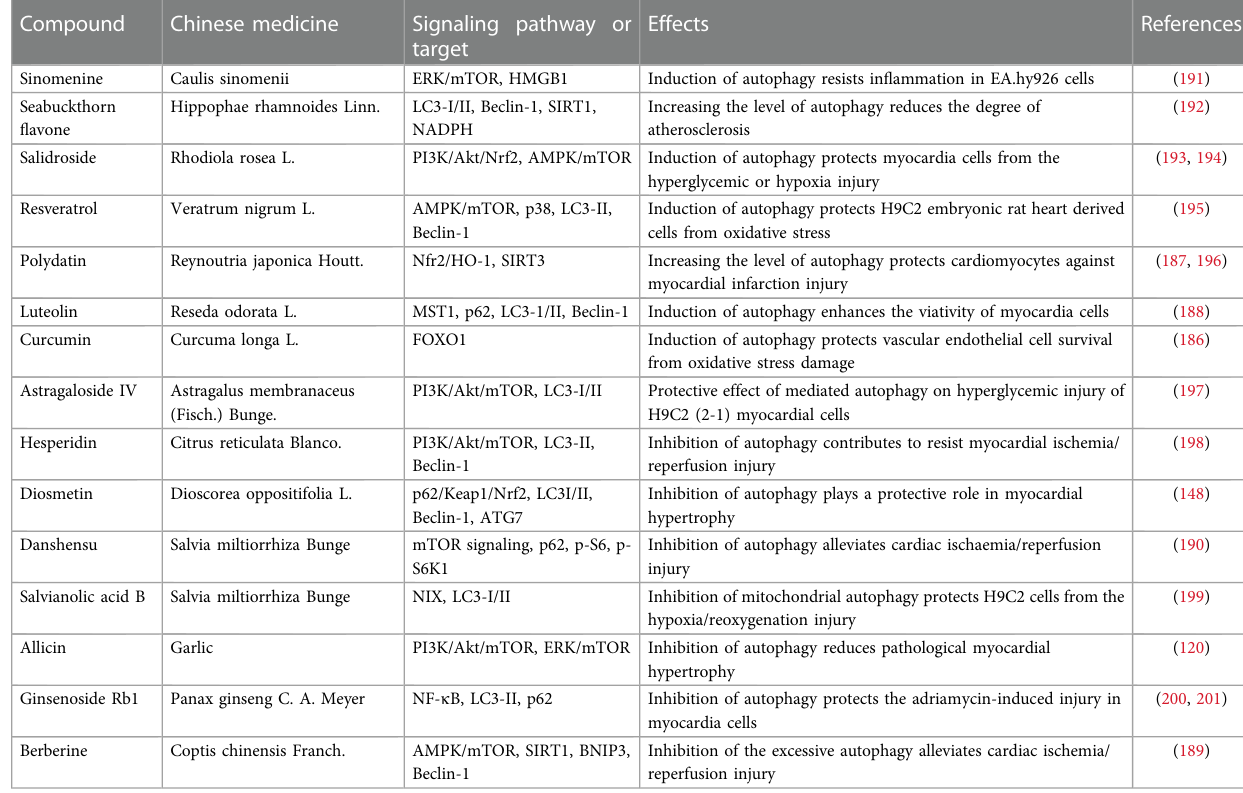
TABLE 2 Chinese medicines mediated-autophagy has doule-sided regulation in cardiovascular